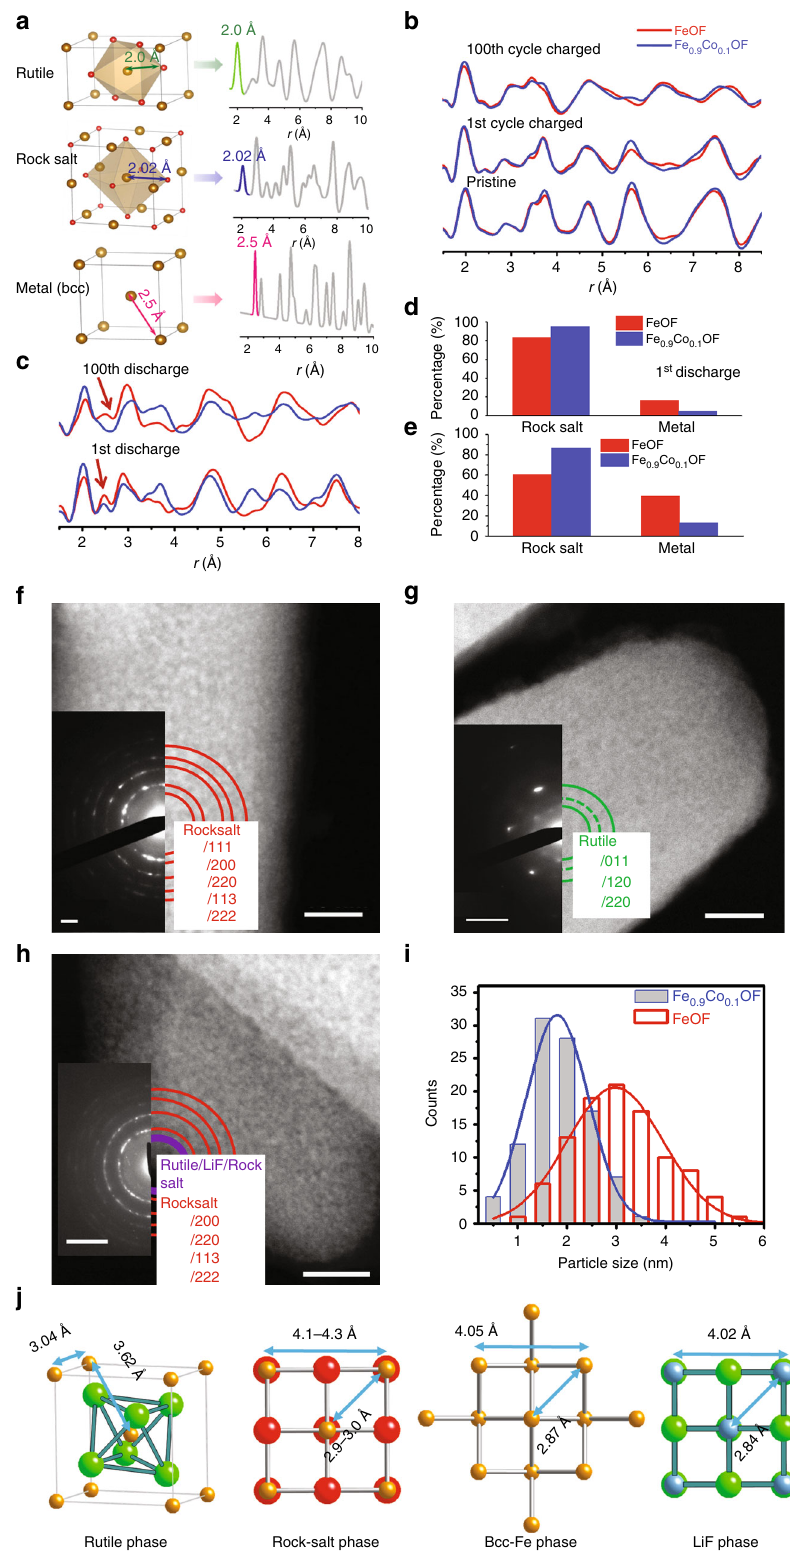
Fig. 3 Microstructure evolution during cycling for the Fe 0.9 Co 0.1 OF cathode material. a Illustration of the correspondence between PDF peaks and speci fi c atomic pairs. b , c PDF patterns of Fe 0.9 Co 0.1 OF and FeOF for different charge and discharge states. d , e The concentration of rocksalt phase, and the metal phase by fi tting PDF results after different discharge states. f – h HRTEM images of Fe 0.9 Co 0.1 OF electrode after discharged to 1.2 V, charged to 4 V, and after 100 cycles discharged, respectively. i The histograms of the metal particle size distribution for Fe 0.9 Co 0.1 OF and FeOF electrodes after discharged to 1.2 V. Insets in f – h are the corresponding SAED patterns. j Illustration of the crystal structures of the four structures during cycling. Scale bar in f – h is 10 nm. Scale bar in the inset of f – h is 2, 5, and 5 nm − 1 ,